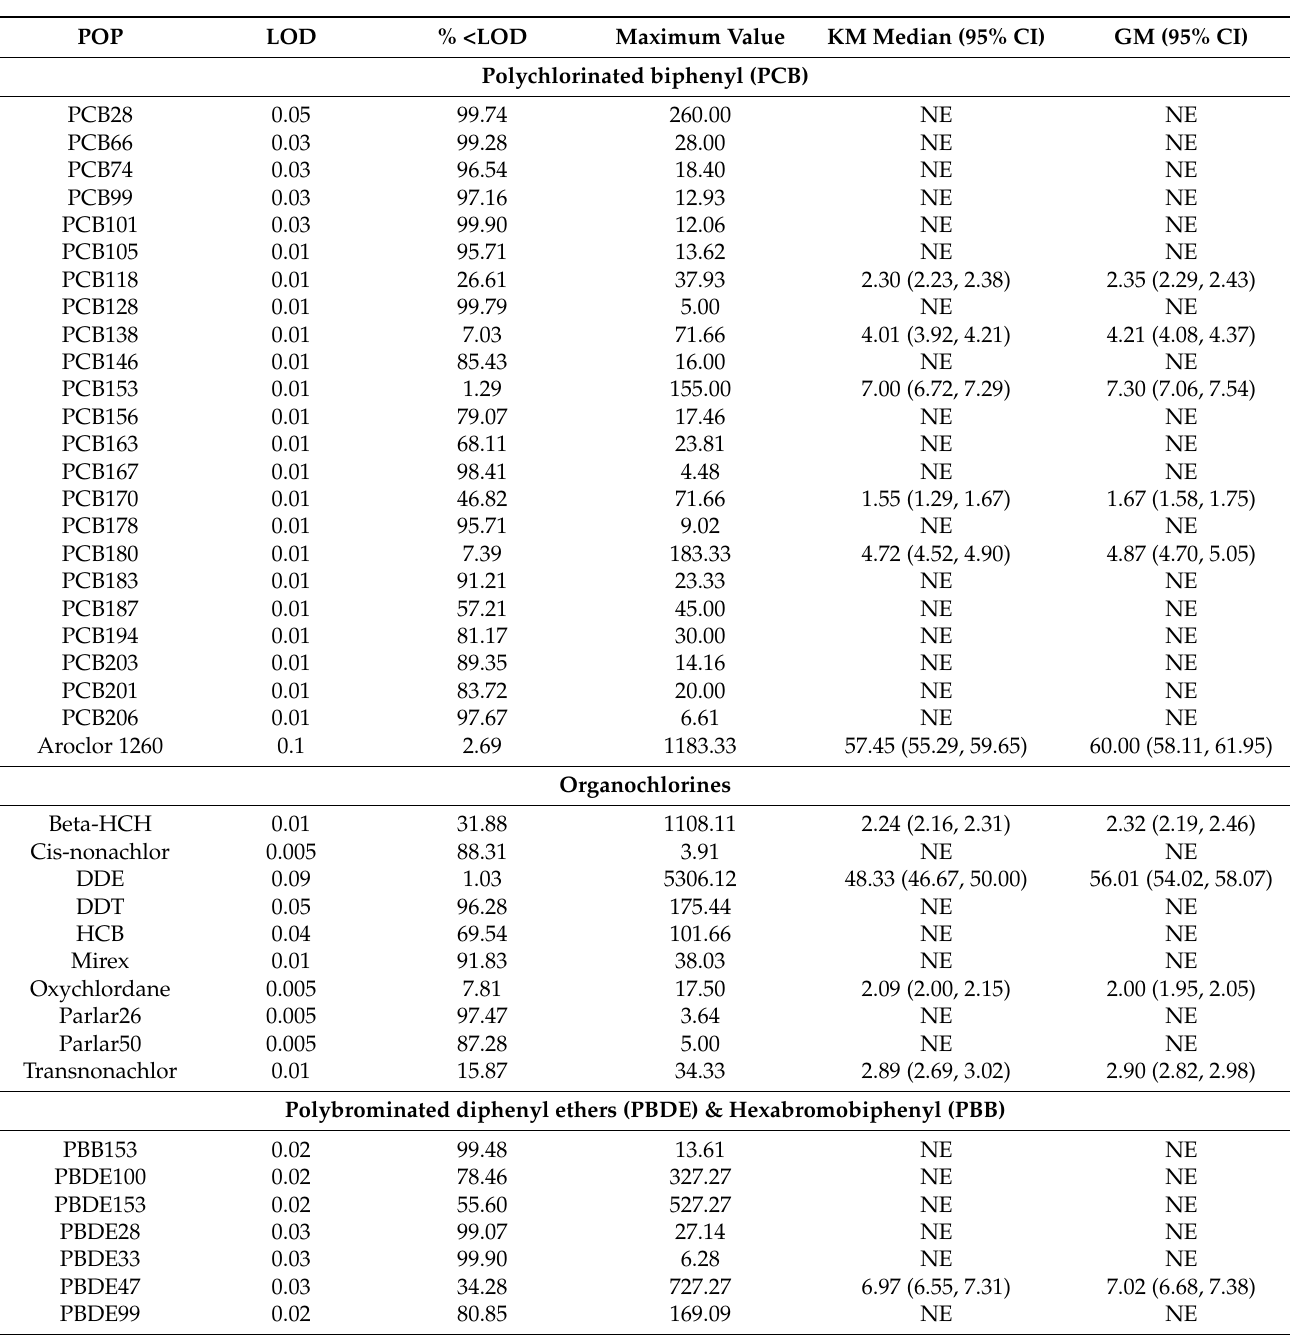
Table 2. Distribution of persistent organic pollutant (POP) concentrations ( µ g per kg serum lipid) in maternal blood plasma in 1983 pregnant women participating in the MIREC